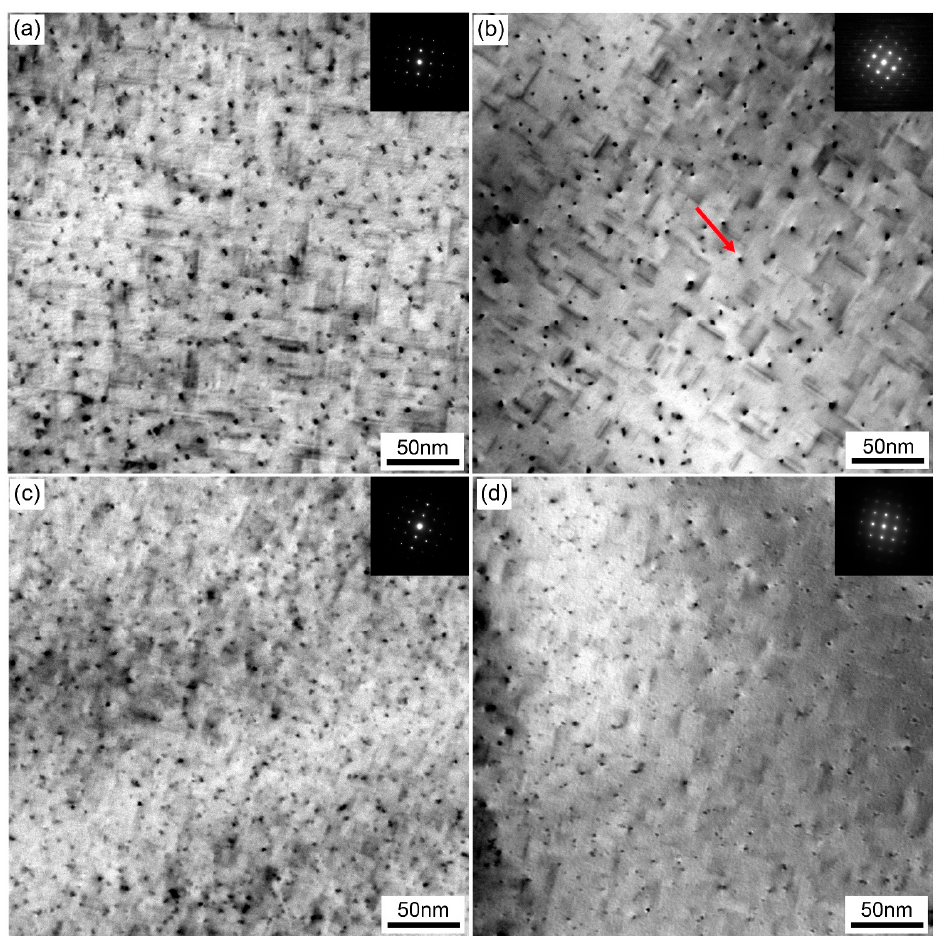
Figure 12. Enlarged TEM bright-field images of samples with different quenching rates after paint bake-hardening at 185 °C for 4 h: ( a ) 58.9 °C/s, ( b ) 7.0 °C/s, ( c ) 2.8 °C/s, and ( d ) 1.6 °C/s.